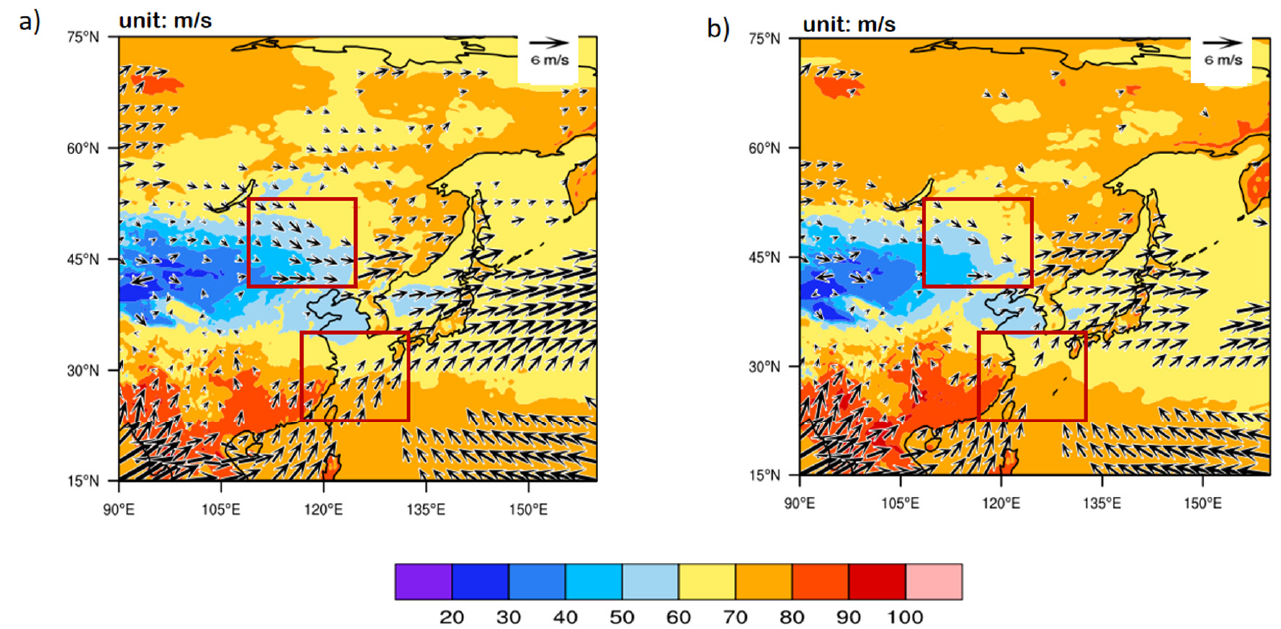
Figure 8. Relative humidity (shaded) and wind (m/s, vectors) components at 850 hPa for the two rainfall patterns in Northeast China during 1961–2019: ( a ) pattern A; ( b ) pattern B; areas reaching 95% significant test are dotted; the red box marks the differences.